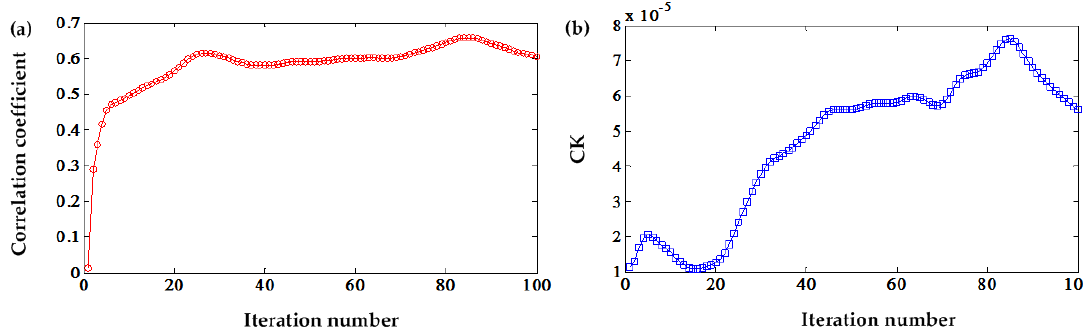
Figure 2. ( a ) Cross-correlation coefficient variation vs. iteration number; ( b ) correlated kurtosis (CK) value vs. iteration number.